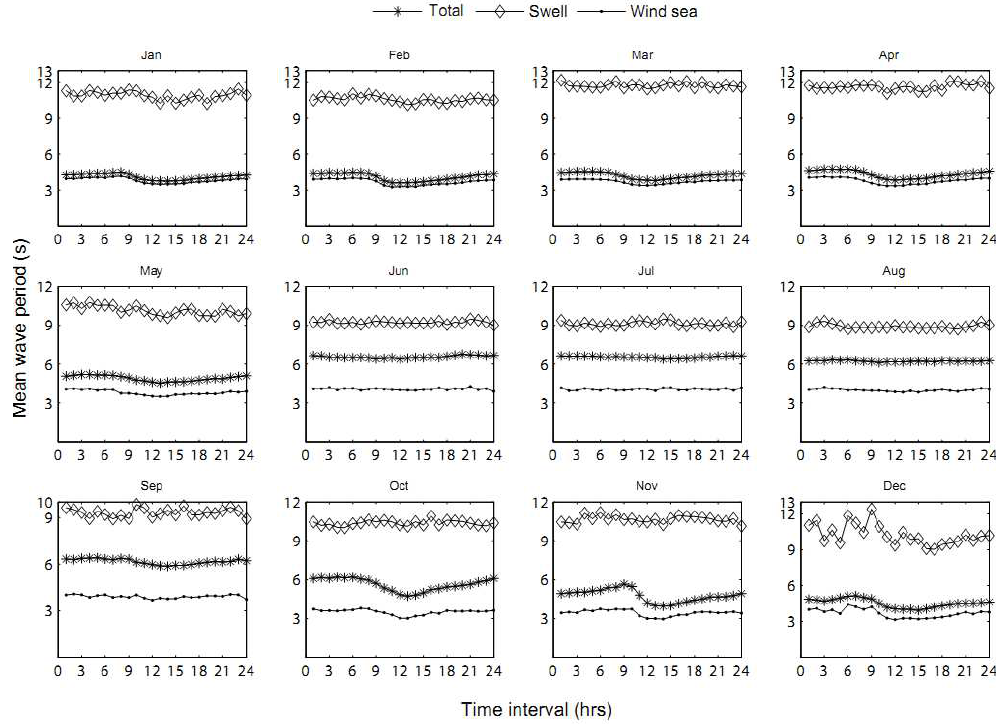
Fig. 3. Hourly variation of mean wave period ( T m 02 ) during 2011, in Figure 3: Hourly variation of Mean wave period (T m02 ) during 2011 in UTC 480